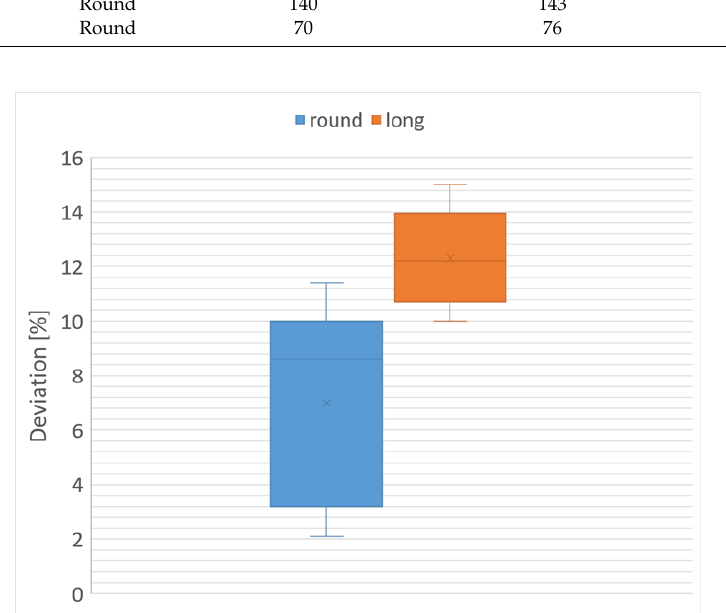
Figure 9. Boxplots for different dough shapes.